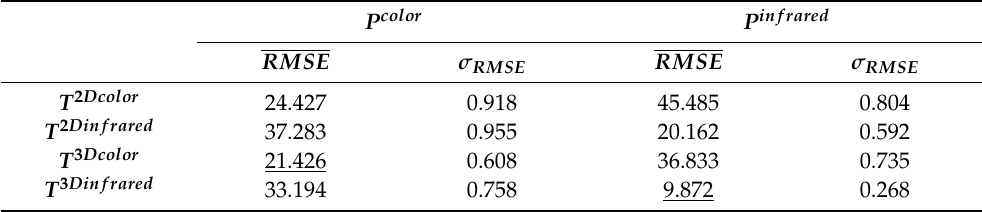
Table 1. Mean and standard deviation of RMSEs calculated between aligned and reference point clouds with static target, where calibration techniques have been applied [mm]. The best results of RMSE are underlined.